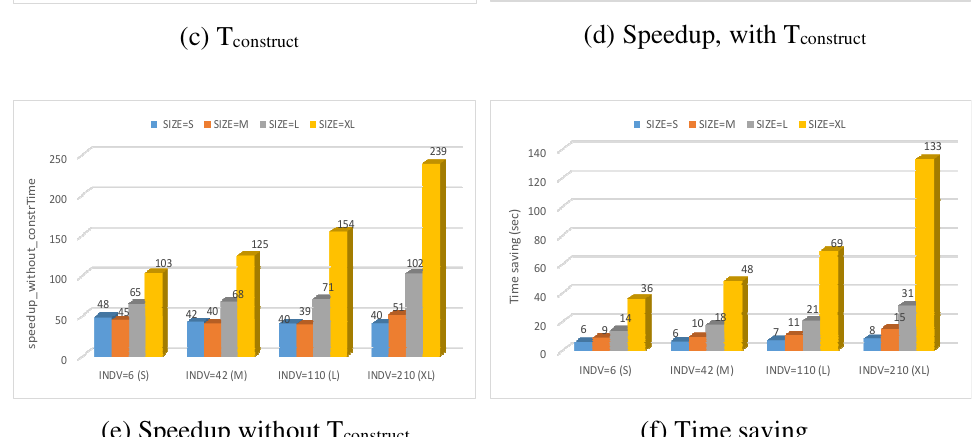
Figure 27. Results for commonality analysis (RT3) for all INDV and SIZE categories. It can be noticed from Figure 27a that T ind in this experiment is at least two times larger than T ind in the previous experiment (i.e., RT2). T MU and T construct , on the other hand, grow at the same pace. Again, times T ind , T MU , and T construct increase as SIZE or INDV increases. The time speedup achieved by using M U is always positive, regardless of whether or not T construct is considered. Figure 27d illustrates that speedup_with_constrTime shows a pattern close to that in RT2, that is, for one SIZE category, e.g., SIZE = S or SIZE = M, the speedup decreases as INDV increases. On the other hand, speedup_without_constrTime is more substantial, and increases as INDV or SIZE increases, as shown in Figure 27e. Finally, the time savings in this experiment (Figure 27f) are more significant than in the experiments for RT2, as the potential gain here is quadratic rather than linear, with about 133 s saved for extra-large families of extra-large